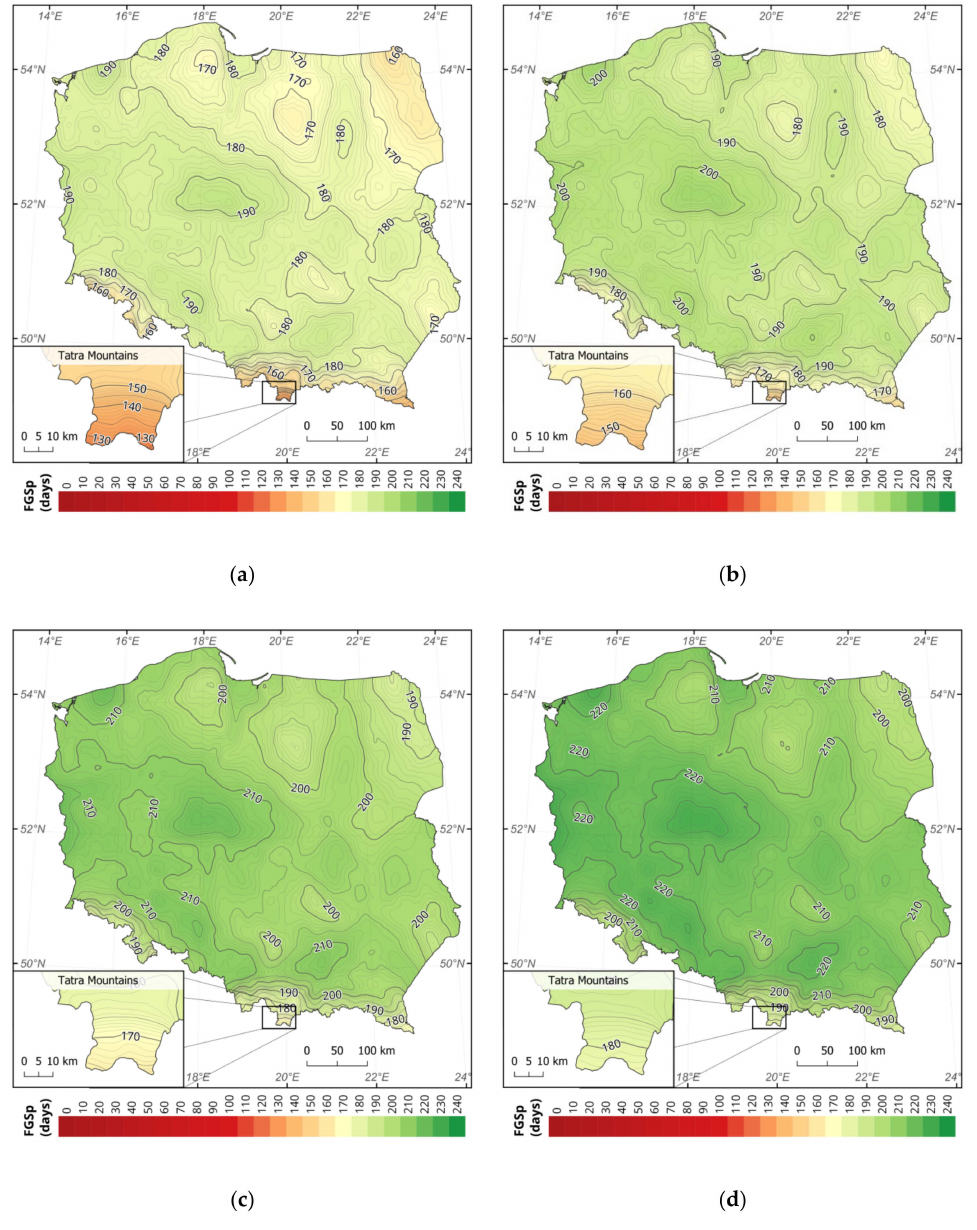
Figure 7. Projected forest growing season (FGSp) in Poland in 2100 based on data from WorldClim 2.1 for analysed CMIP6 climate scenarios SSP1-2.6 ( a ), SSP2-4.5 ( b ), SSP3-7.0 ( c ) and SSP5-8.5 ( d